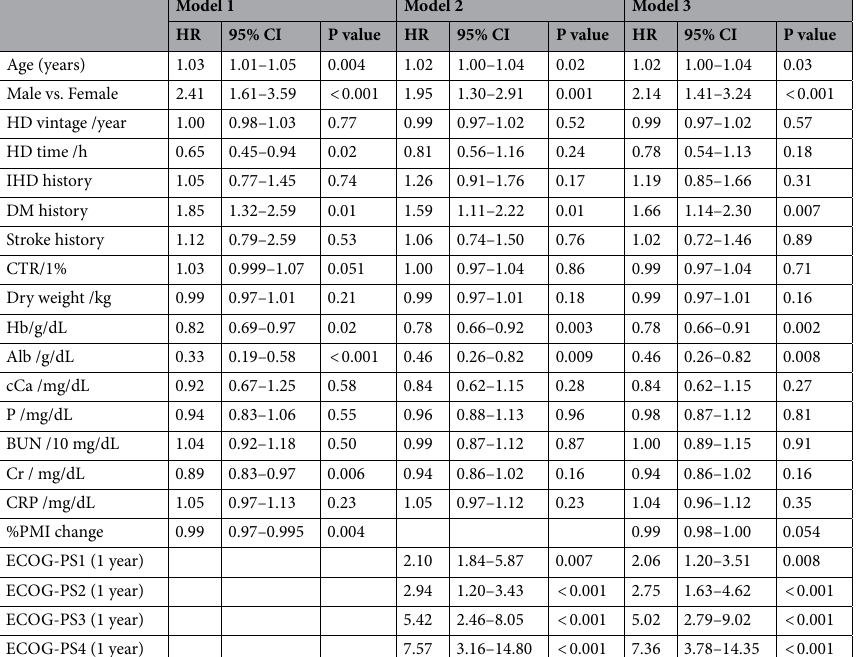
Table 5. Multivariable Cox regression analysis for all-cause mortality. Model 1: The predetermined factors and %PMI adjusted; Model 2: The predetermined factors and ECOG-PS adjusted; Model 3: The predetermined factors and %PMI and ECOG-PS adjusted. HR hazard ratio, CI confidence interval, HD hemodialysis, IHD ischemic heart disease, DM diabetes mellitus, CTR cardiothoracic ratio, DW dry weight, Hb hemoglobin, Alb albumin, cCa corrected calcium, P phosphate, BUN blood urea nitrogen, Cr creatinine, TC total cholesterol, CRP C-reactive protein, ECOG-PS Eastern Cooperative Oncology Group performance